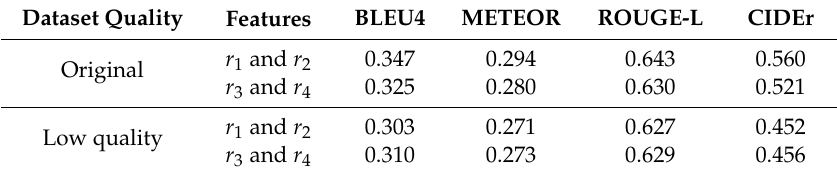
Table 2. Description performance of the high and low quality features in the proposed network, when the original MSVD dataset and its low quality dataset were used for the network training,